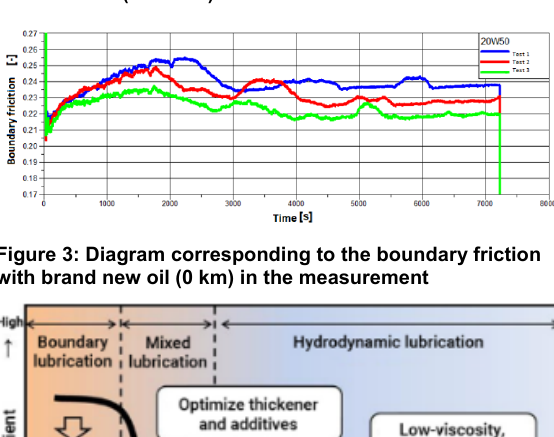
Figure 2: Diagram corresponding to the boundary friction with used oil (1000 km) in the measurement